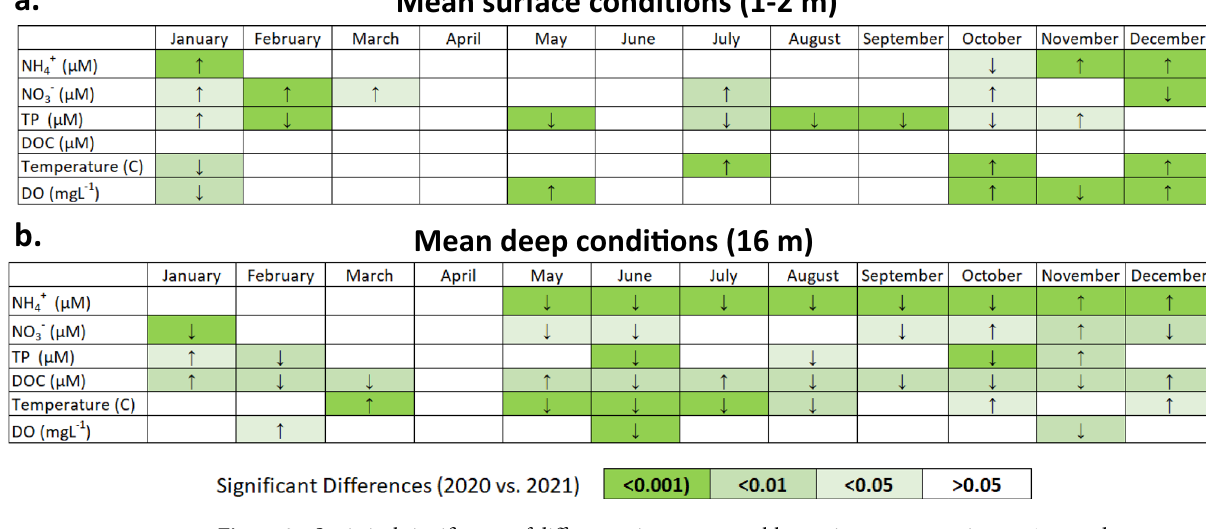
Figure 3. Statistical significance of differences in mean monthly nutrient concentrations at 1 m, and temperature and dissolved oxygen at ( a ) 1–2 m (2020 vs. 2021) and ( b ) 16 m. Arrows indicate direction of change (2020 to 2021) in months where p < 0.05 (i.e., ↑ indicates an increase in 2021 compared to 2020 whereas ↓ indicates a decrease in 2021 compared to 2020). Cell color denotes p value (2020 vs. 2021, ANOVA).